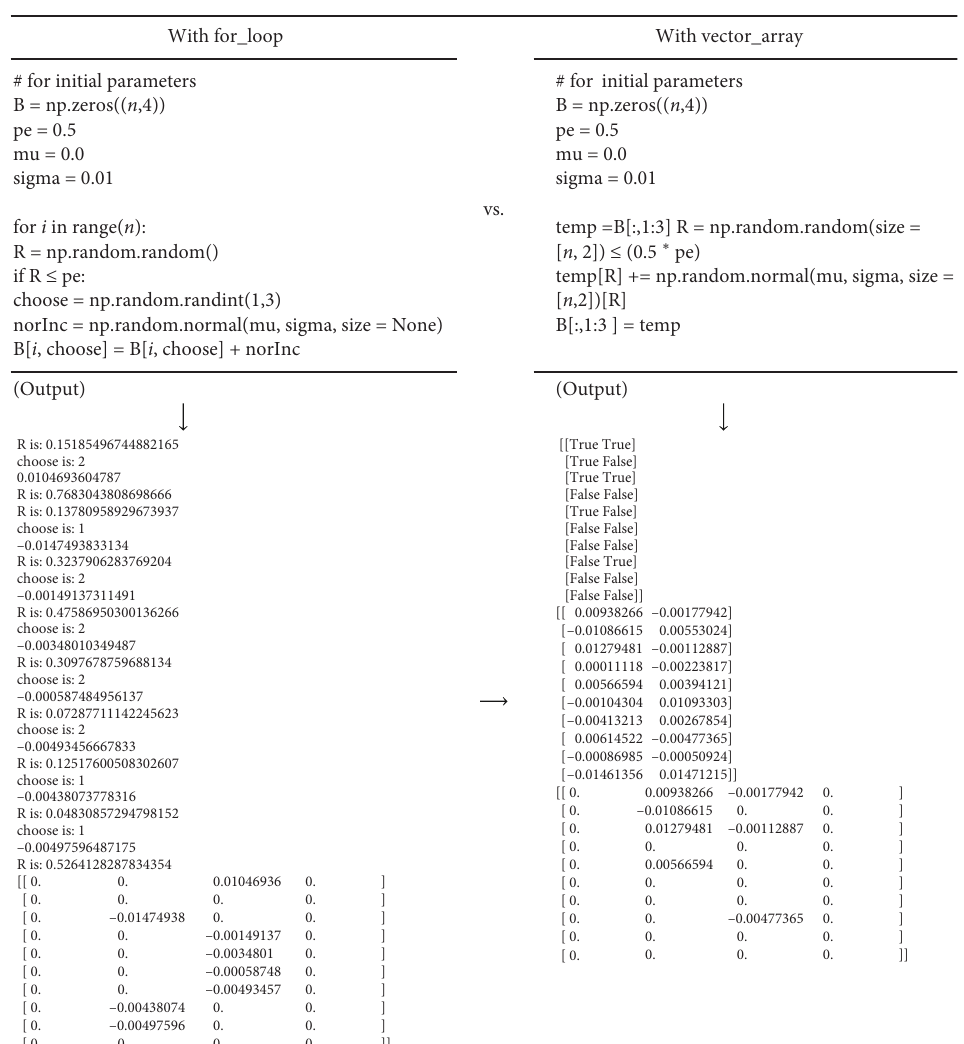
Figure 15: Numerical results using a loop (left side) and an array (right